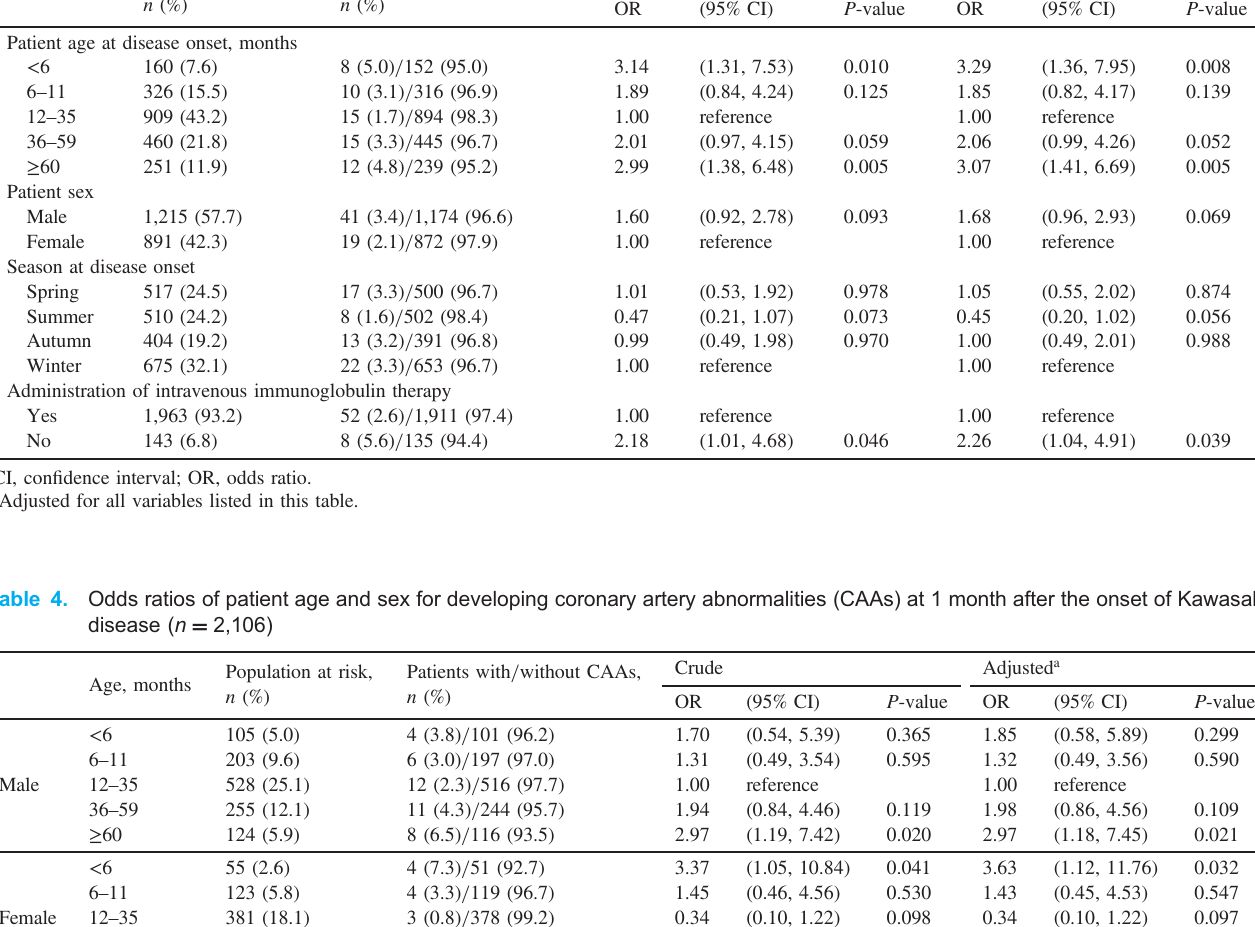
Table 3. Odds ratios for coronary artery abnormalities (CAAs) at 1 month after the onset of Kawasaki disease ( n = 2,106) Population at risk, Patients with = without CAAs, n (%) Patient age at disease onset, months <6